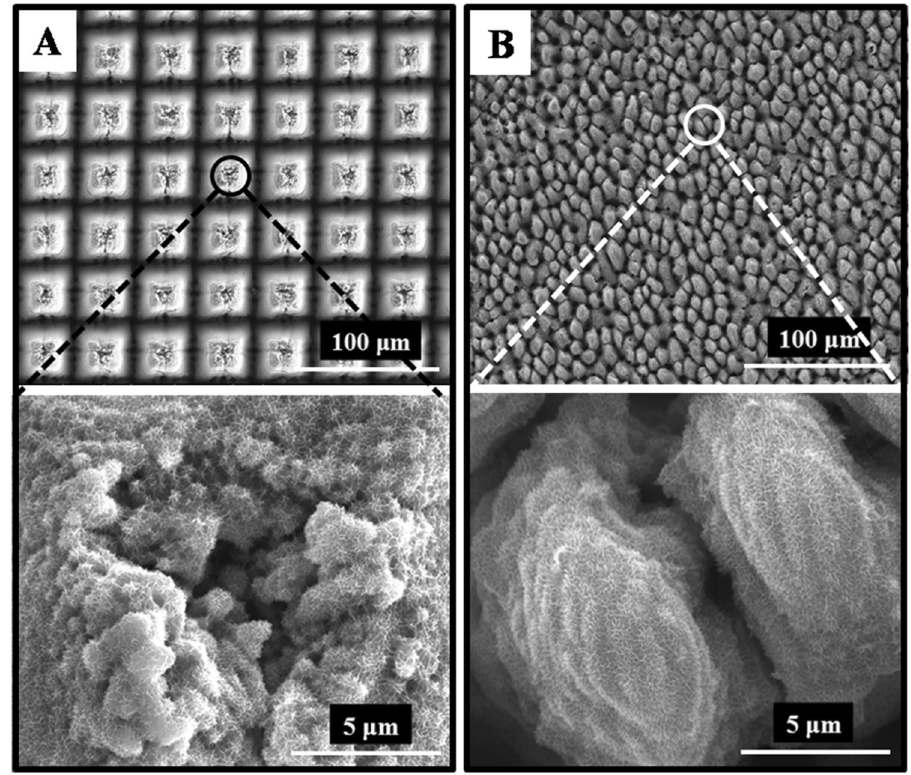
Figure 6. FESEM images of annealing-TiO 2 with different morphology and size ( A ) Square microarray, and ( B ) Conical